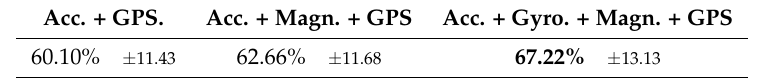
Table 10. Mean accuracies achieved for each set of data, with the best group result highlighted in bold. Acc. + GPS.